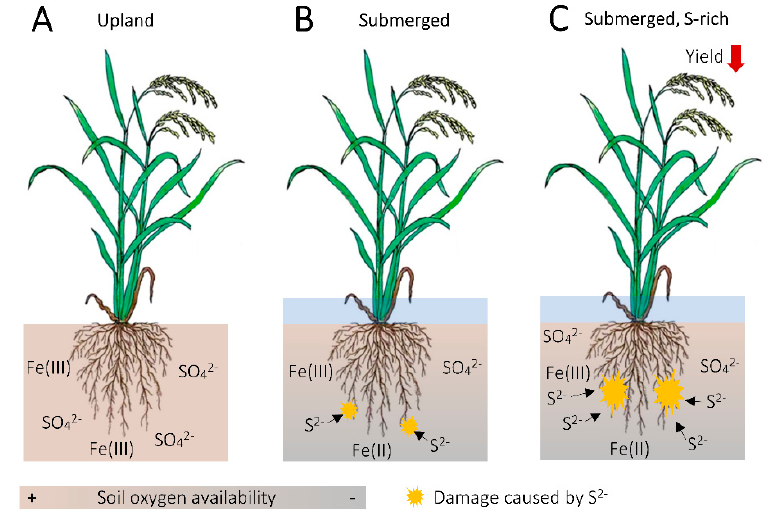
Figure 3. Schematic representation of the occurrence of rice sulfide toxicity as affected by water management practice and soil sulfur (S) availability. ( A ) In upland conditions, the majority of S in soil exists in oxidized forms (SO 42 − ) due to high availability of oxygen in the soil. ( B ) Prolonged submergence leads to S reduction in deep soil, where anerobic condition prevails. ( C ) S abundance in the soil can further promote sulfide (S 2 − ) occurrence, leading to higher risk of sulfide toxicity in rice, ultimately resulting in yield loss.